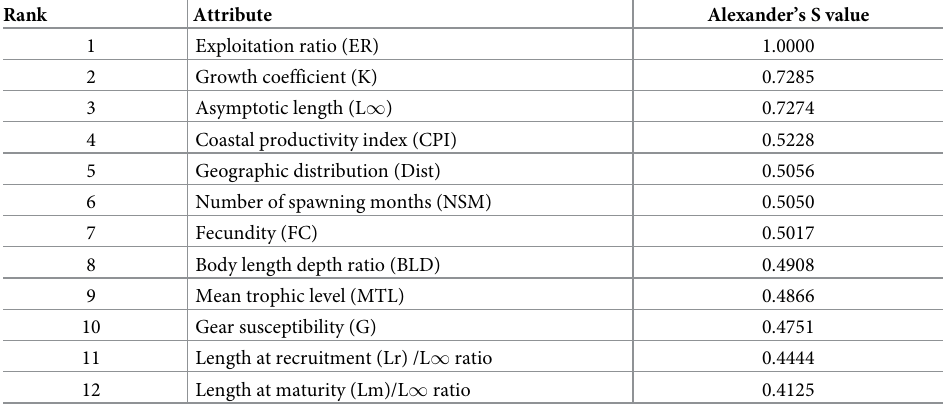
Table 7. Alexander’s sensitivity analysis results scaled to unity showing the attributes ranked according to